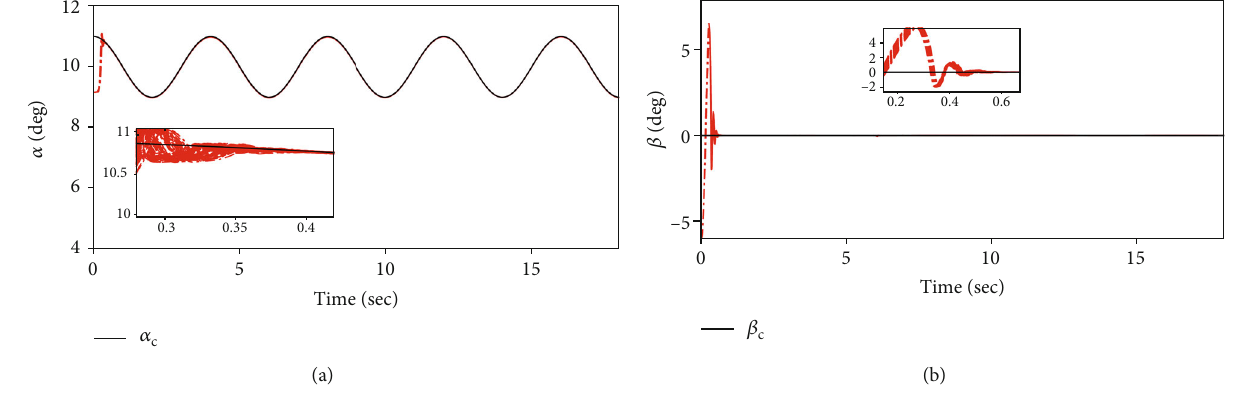
Figure 8: Tracking e ff ect of yaw and pitch commands.